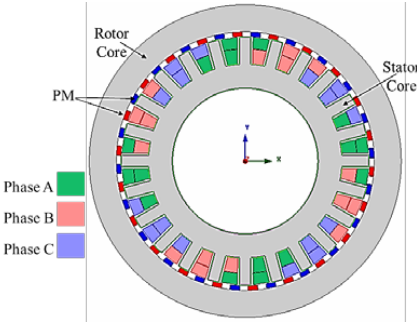
Figure 14. 2D model for equivalent permanent magnet vernier machine (PMVM).